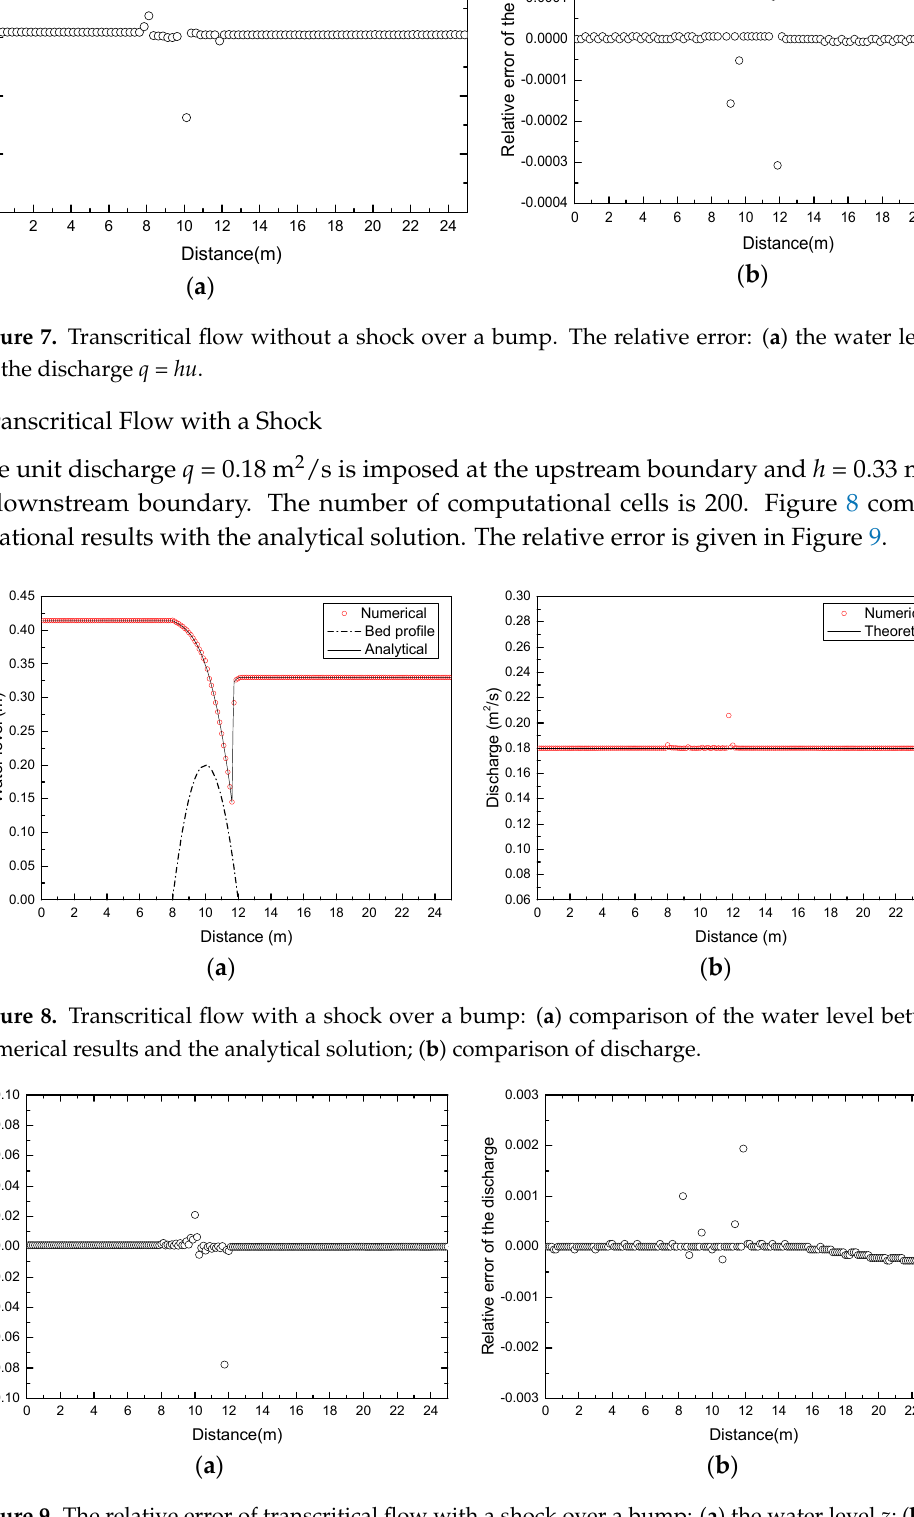
Figure 9. The relative error of transcritical flow with a shock over a bump: ( a ) the water level z ; ( b ) the discharge q = hu .